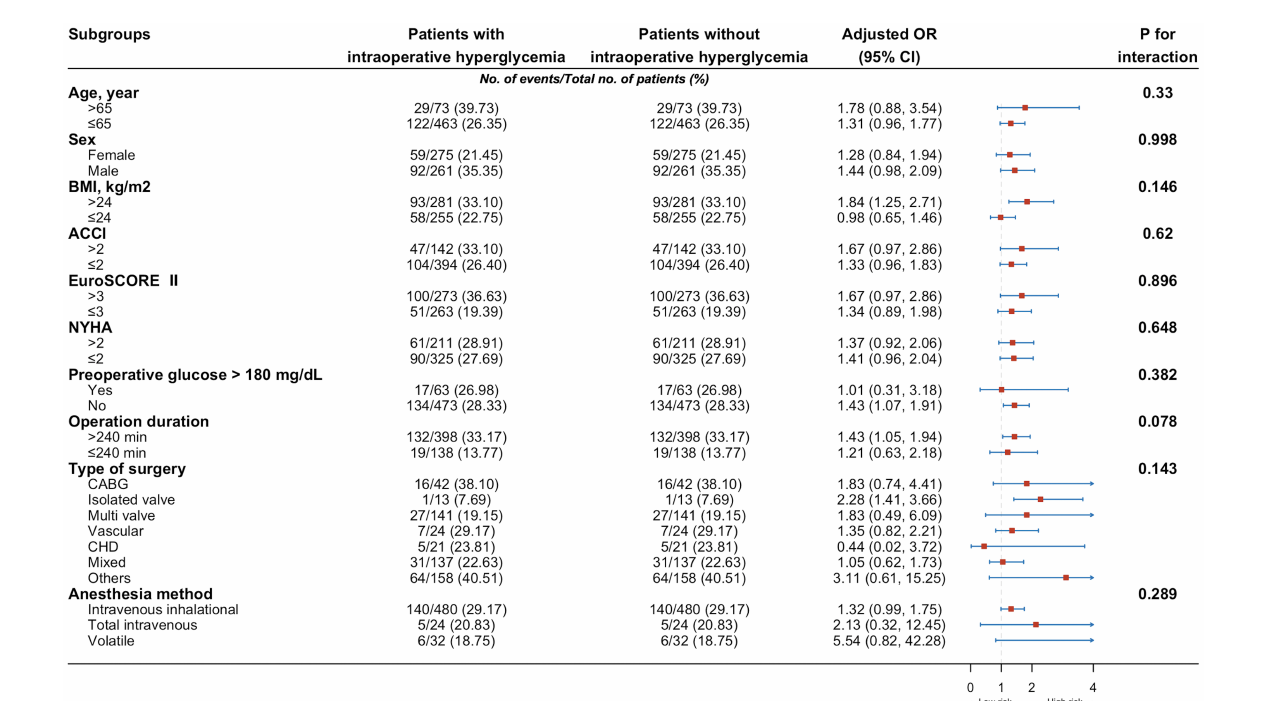
FIGURE3 Risk of infection among individuals with intraoperative hyperglycemia by different characteristics, compared with that of individuals without such conditions. ACCI, Aged-adjusted Charlson Index; BMI, body-mass index; CABG, coronary artery bypass grafting; CHD, congenital heart disease; CI, confident interval; EuroSCORE II, European system for cardiac operative risk evaluation II; NYHA, New York Heart Association Classification; OR, odds ratio.